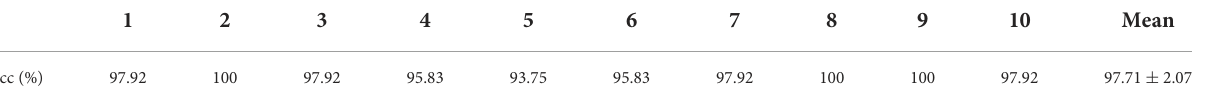
TABLE 1 Offline accuracies of the CNN–GA for S2.